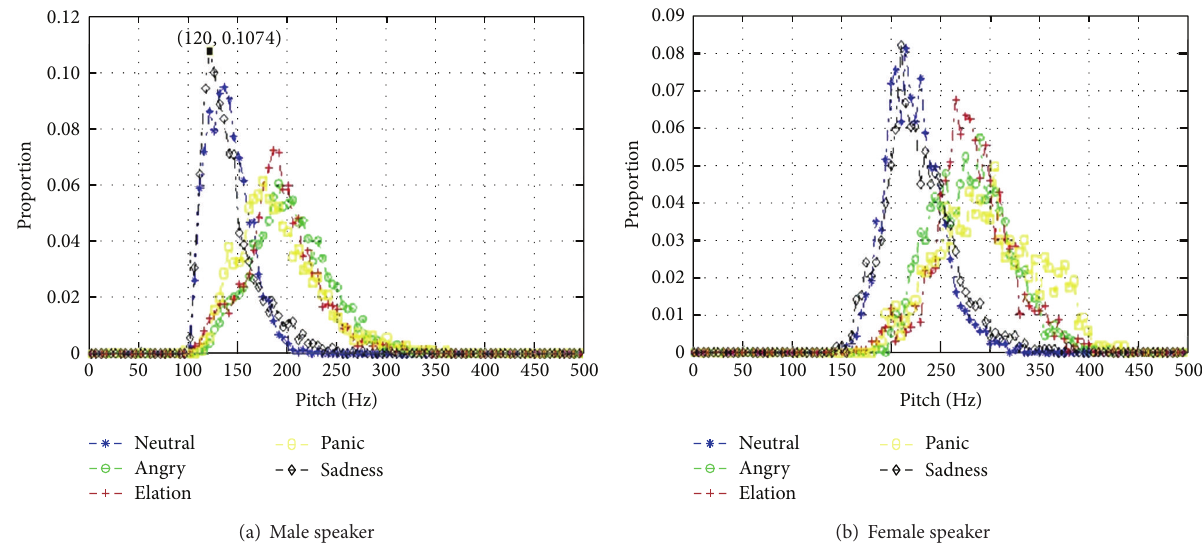
Figure 2: The probability distribution of PEM for the male (a) and female speakers (b) under the five emotion states.